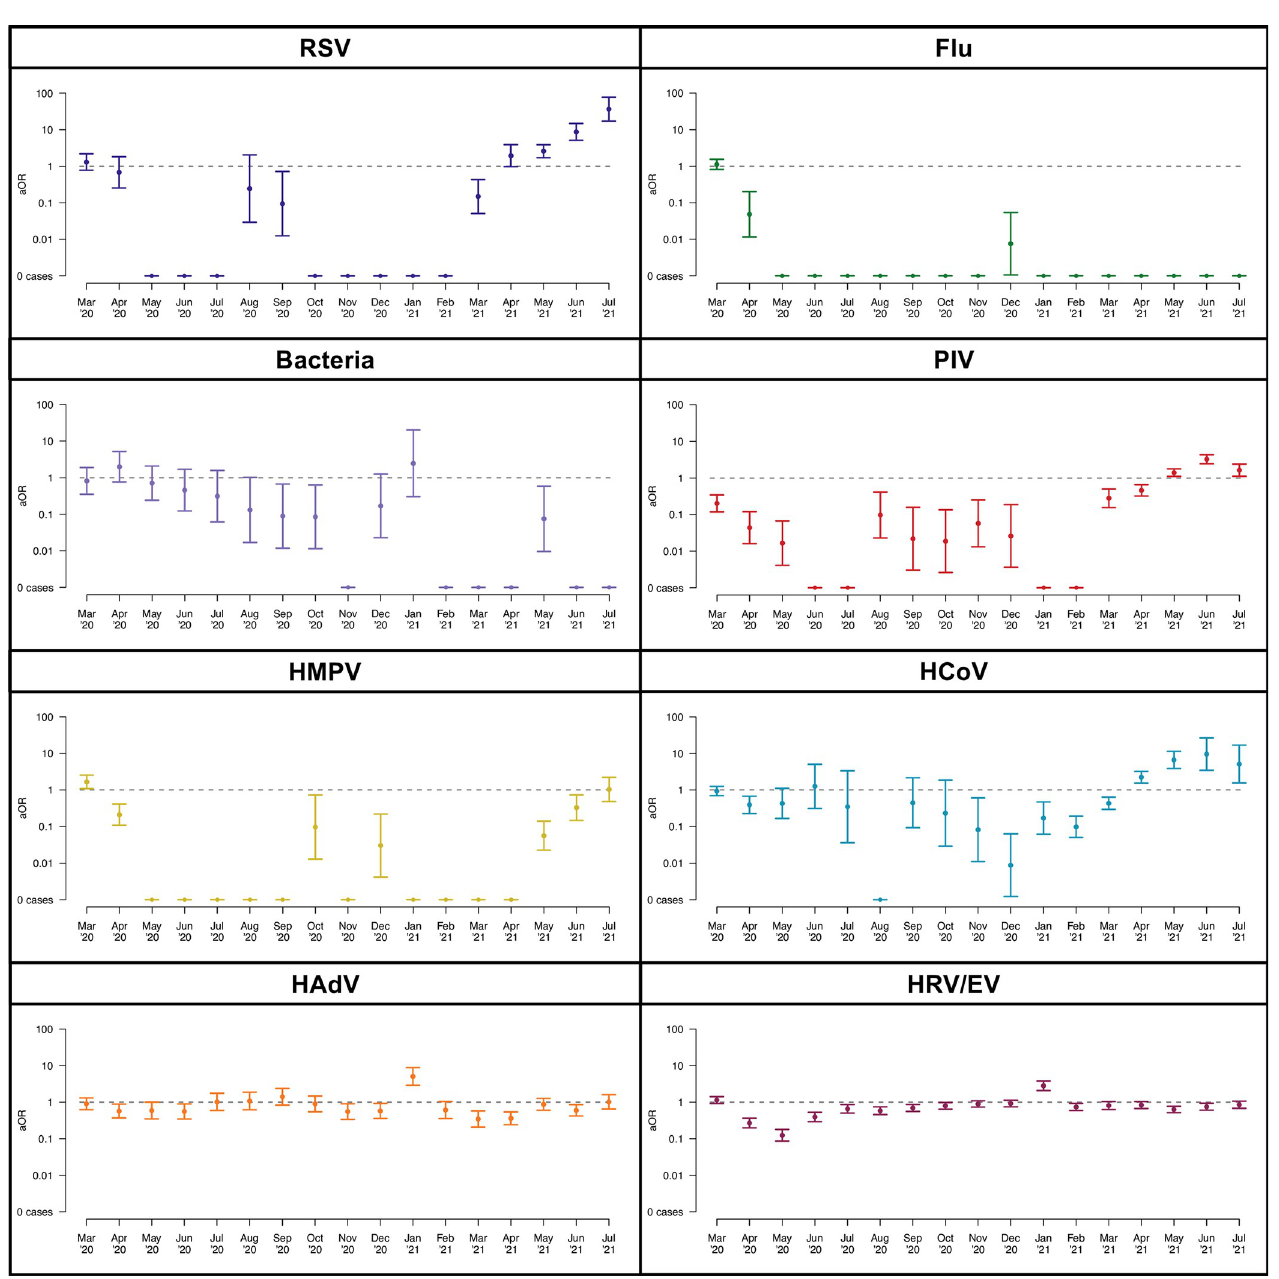
Fig 3. Virus-specific odds ratios, comparing the odds of a positive test result, for each month over the SARS-CoV-2 pandemic period (March 2020 through July 2021) to the same respective months during prior non-pandemic years. Abbreviations: RSV, respiratory syncytial virus; Flu, influenza; PIV, parainfluenza virus; HMPV, human metapneumovirus; HCoV, human coronaviruses; HAdV, human adenovirus; HRV/EV, human rhinovirus/enterovirus.